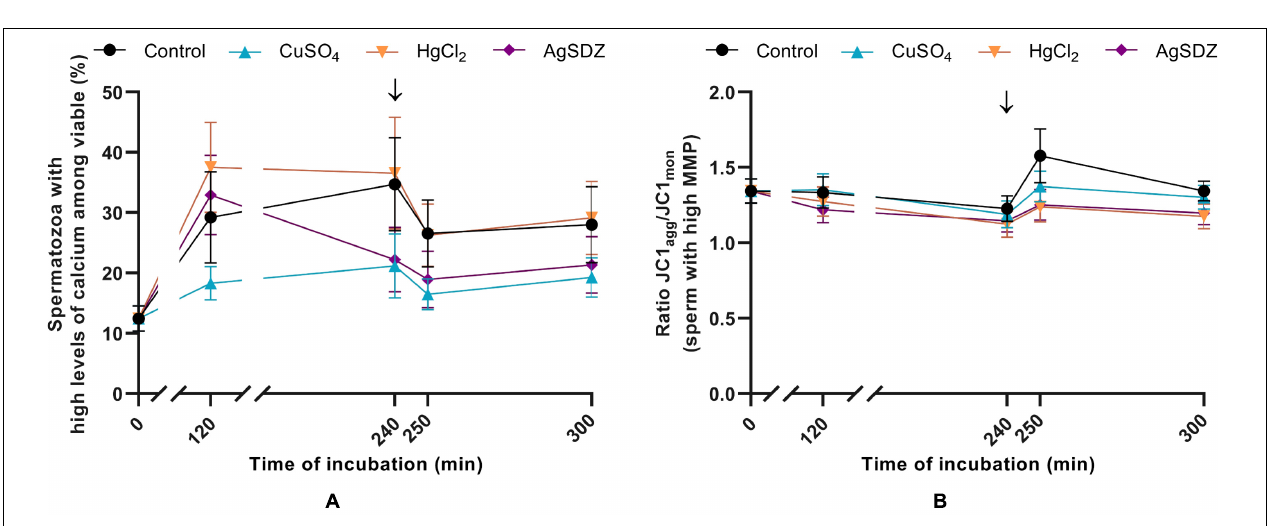
FIGURE 4 | Intracellular levels of calcium and mitochondrial membrane potential. (A) Percentages of spermatozoa with high levels of intracellular calcium within the viable sperm population (%) and (B) ratio of JC1 agg /JC1 mon intensity of fluorescence in the population of spermatozoa with high MMP in samples exposed to the presence or absence of different AQP inhibitors in the capacitation medium: cooper sulfate (CuSO 4 ), mercury chloride (HgCl 2 ) and silver sulfadiazine (AgSDZ). Data were collected after 0, 120 and 240 min of incubation in capacitation medium. At this point, progesterone was added to capacitation medium (arrow) and data were collected after further 10 min and 60 min of incubation. Data are shown as mean ± SEM, and different letters (a,b) indicate significant differences ( P < 0.05) between different treatments within a given time point.